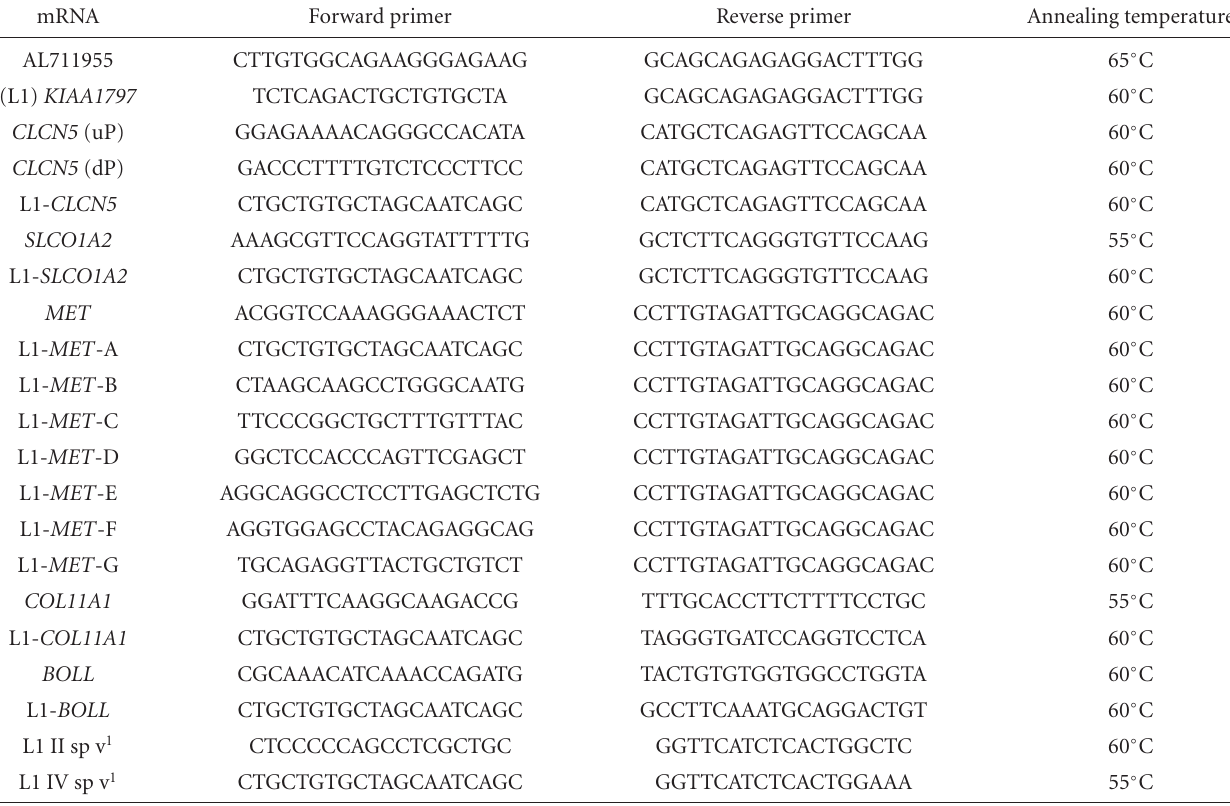
Table 1: Primers used for the detection of mRNAs, chimeric mRNAs, and L1 splice